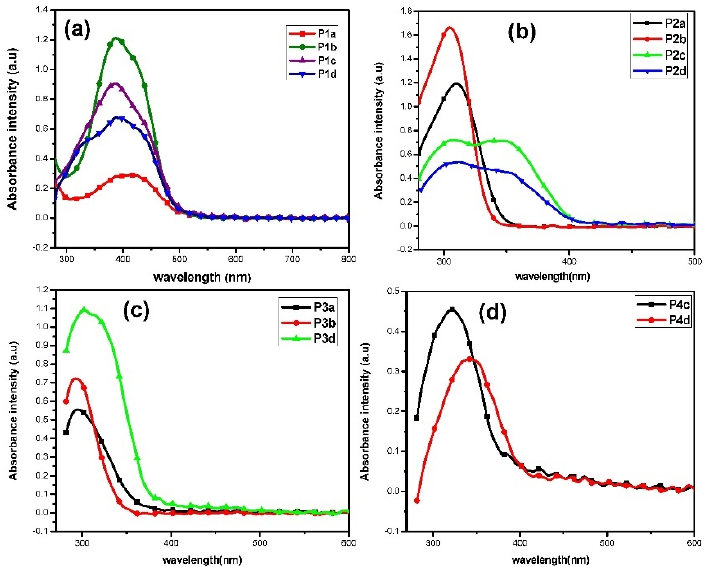
Figure 3. UV-vis absorption spectra of ( a ) P1a–d, ( b ) P2a–d, ( c ) P3a,b,d, and ( d )